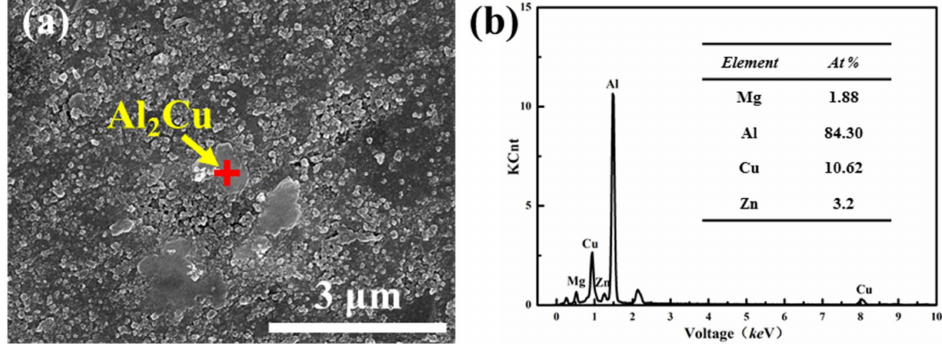
Figure 8. The microstructure of S30 sample ( a ) SEM micrograph and ( b ) energy-dispersive spectroscopy (EDS) analysis of secondary phase.